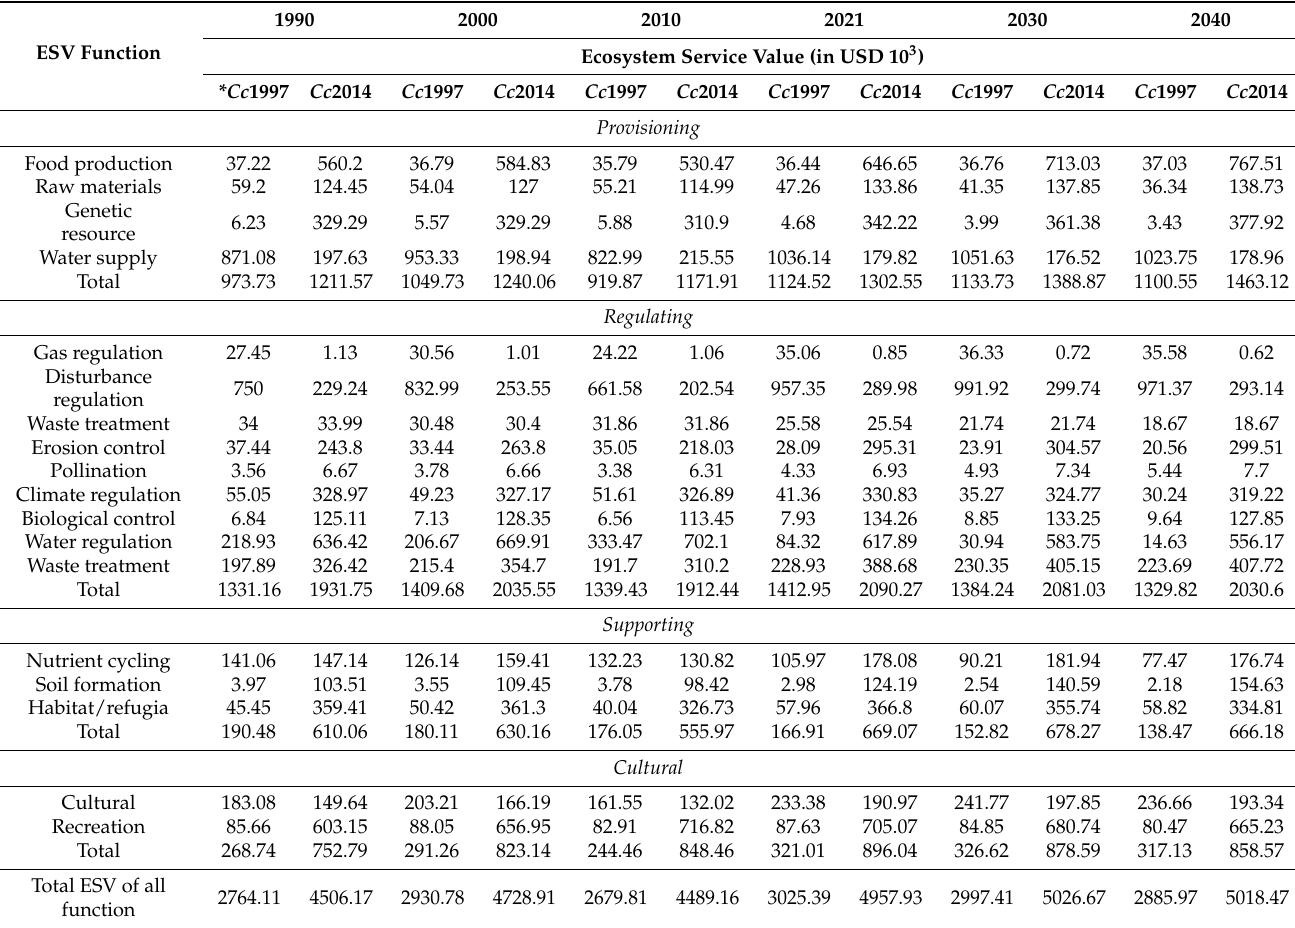
Table 9. Estimated values for different ecosystem functions in the study area in the period 1990–2040.